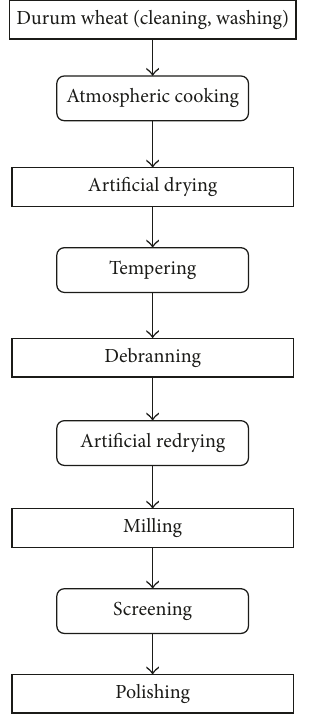
Figure 1: Production flow chart of Antep type